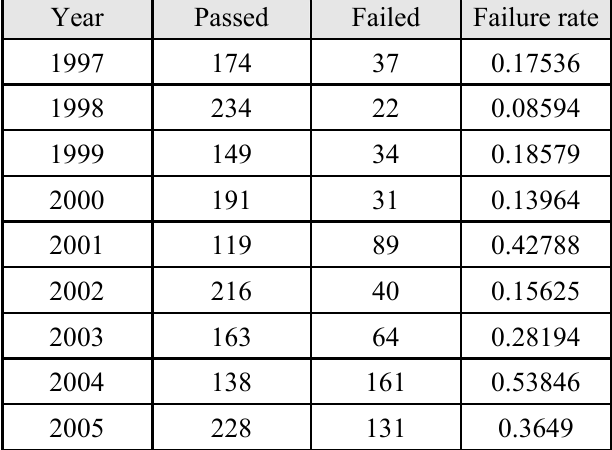
Table 1. The number of passes and fails